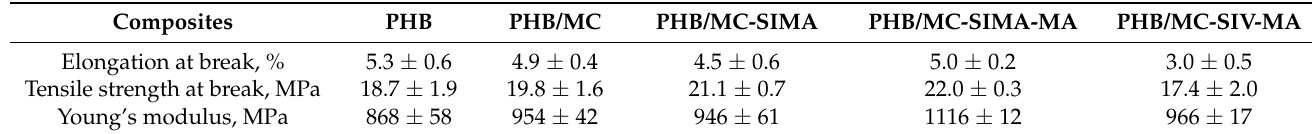
Table 5. Tensile properties data of composites.